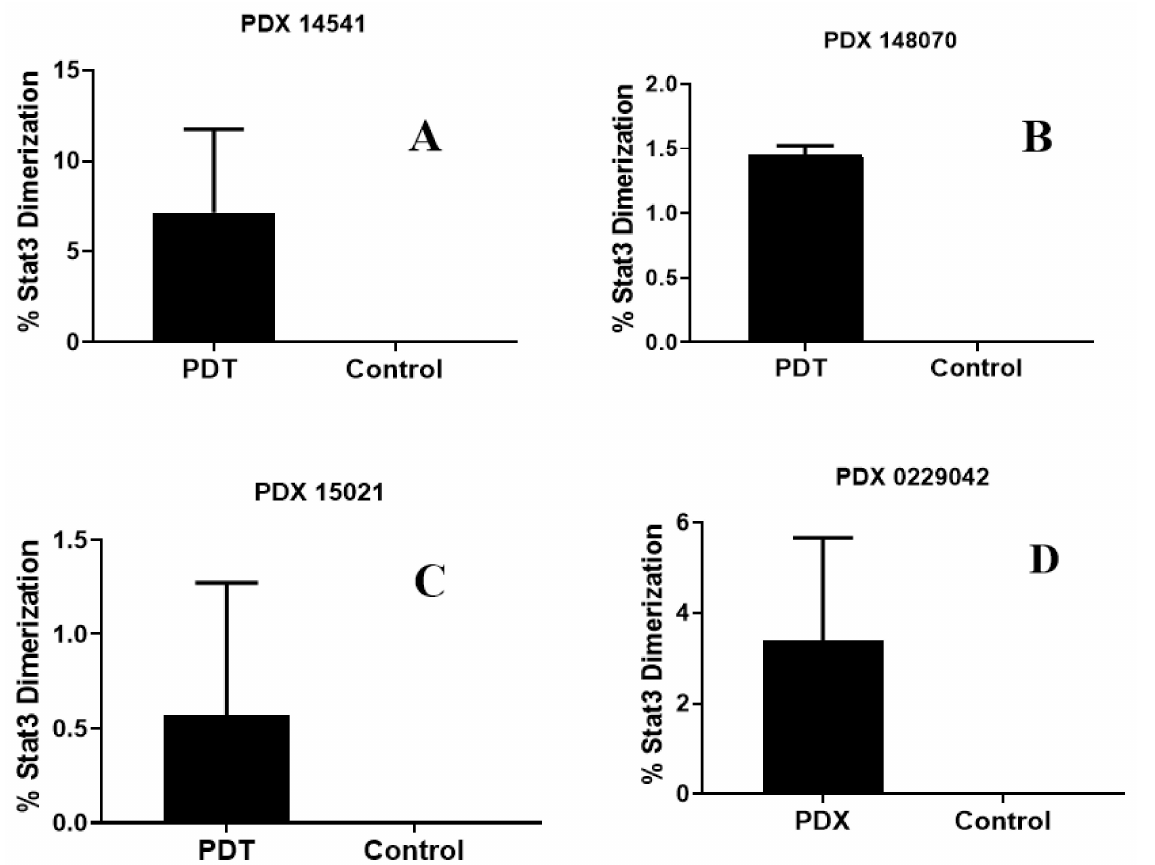
Figure 11. Percentage of STAT3 dimerization measured after in vivo PDT in SCID mice (3 mice/group) bearing tumors on the flank with patient-derived lung cell carcinoma SCC 14541 ( A ), USCLC 148070 ( B ), adenocarcinoma NSCLC 15021 ( C ) , and squamous cell carcinoma, SCC 0229047 ( D ). Tumors were grown for approximately 2 weeks until they reached 6–10 mm diameter; the mice were then injected with 1.0 µ mol/kg PS 1 in 2% Pluronic ® F-127 formulation. In each set of experiments, PDT treatment was given to two mice at 24 h with light at 665 nm at a dose of 135 J/cm 2 and fluence rate of 75 mW/cm 2 . One mouse in each experiment also received PS 1, but no light treatment and used as a